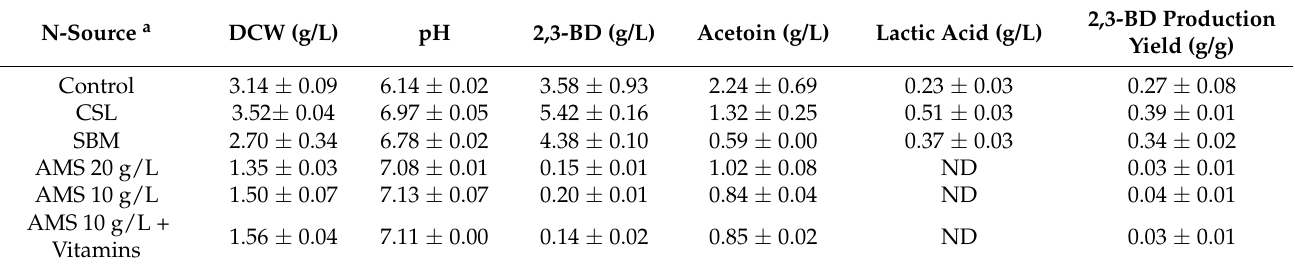
Table 2. Effect of different nitrogen sources on biomass and 2,3-BD production by B. subtilis at 24 h cultivated under aerobic conditions in MMRS medium.